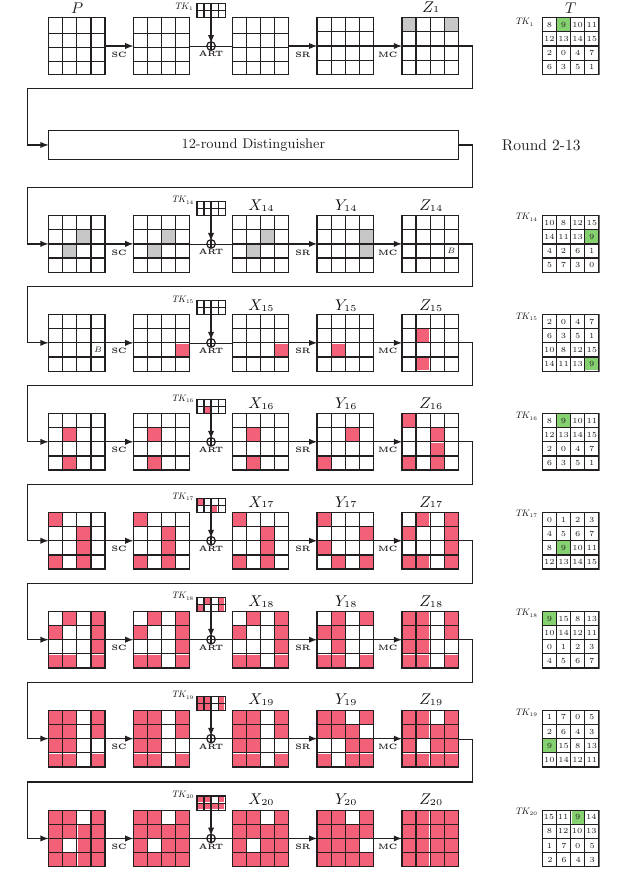
Figure 20: Key-recovery attack on 20 rounds of Skinny